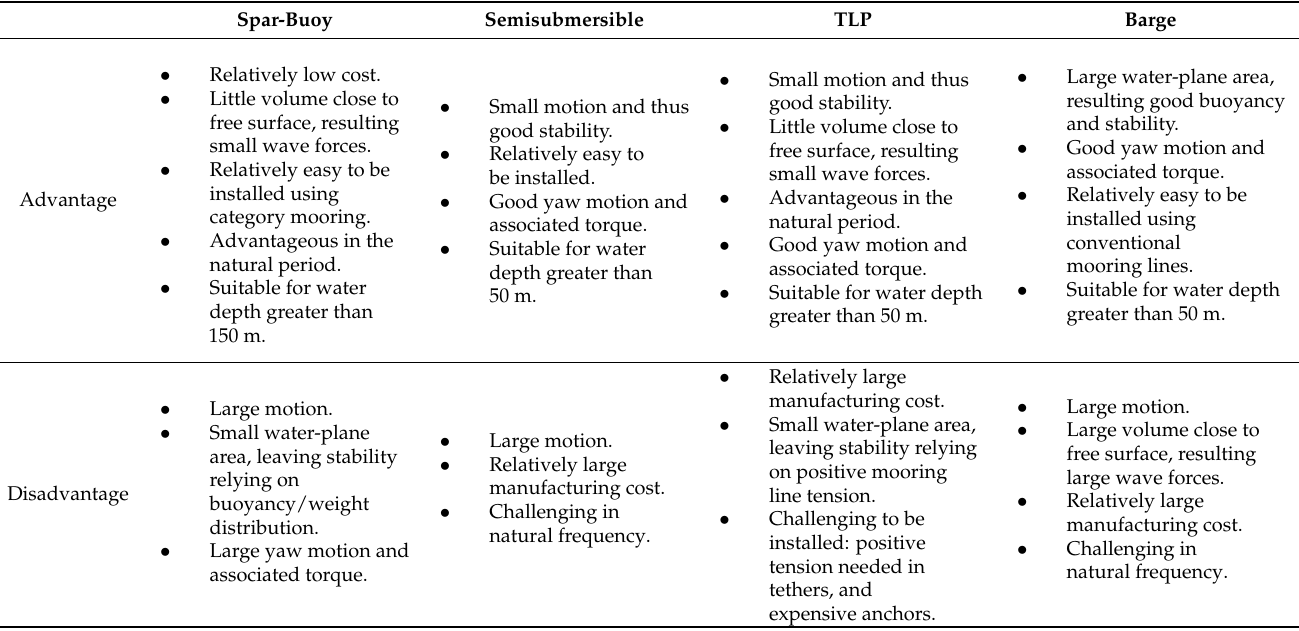
Table 2. Comparison of Substructures for Floating Offshore Wind